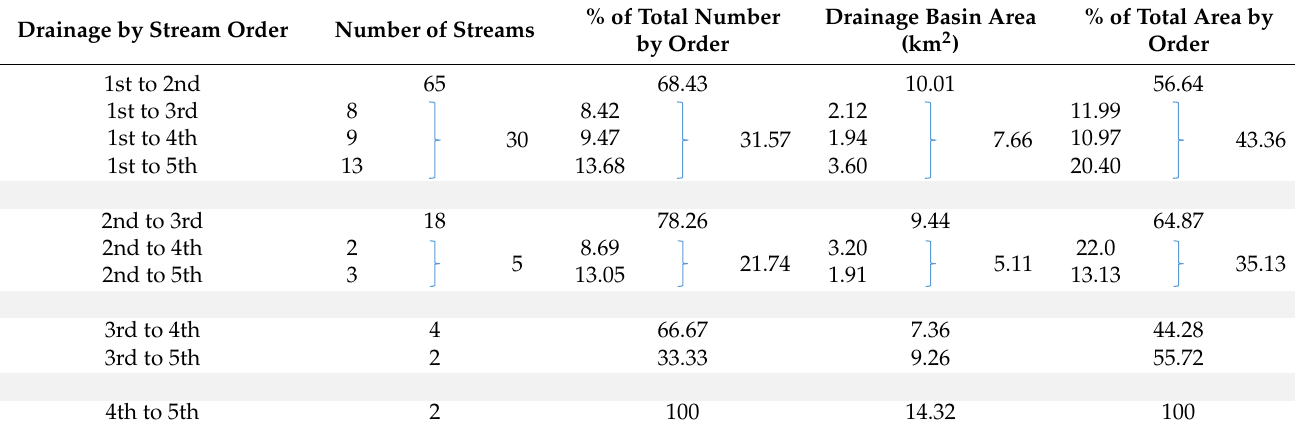
Table 3. Hierarchical drainage for the Kladeos drainage